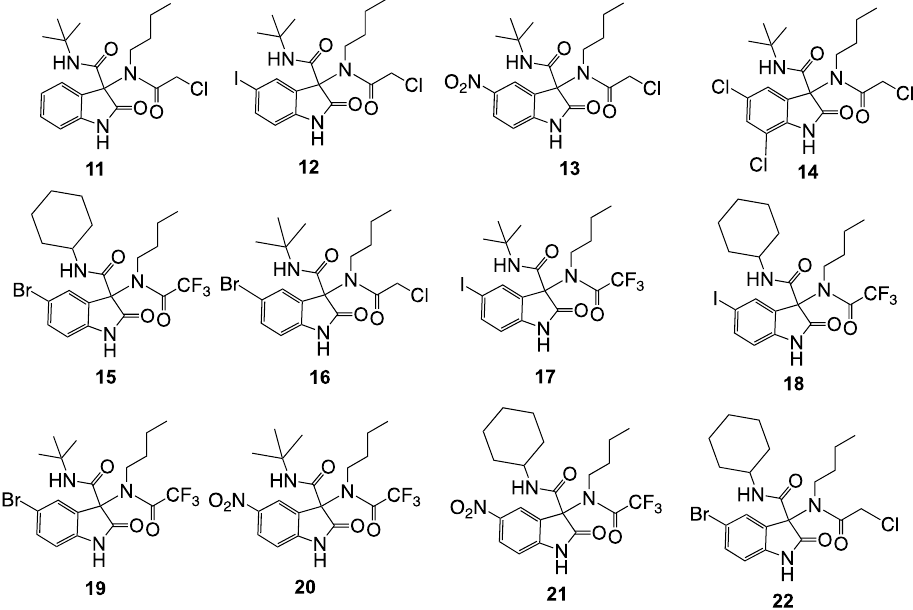
Chart 1. Chemical structures of the isatin compounds synthesized (series 1). Compounds 1 : (X = H), 2 (X = I), 3 (X = Br), 4 (X = NO 2 ), 5 (X = Cl, X 7 = Cl). Table 1. General conditions for the synthesis of the series 1 (compounds 11 – 22).